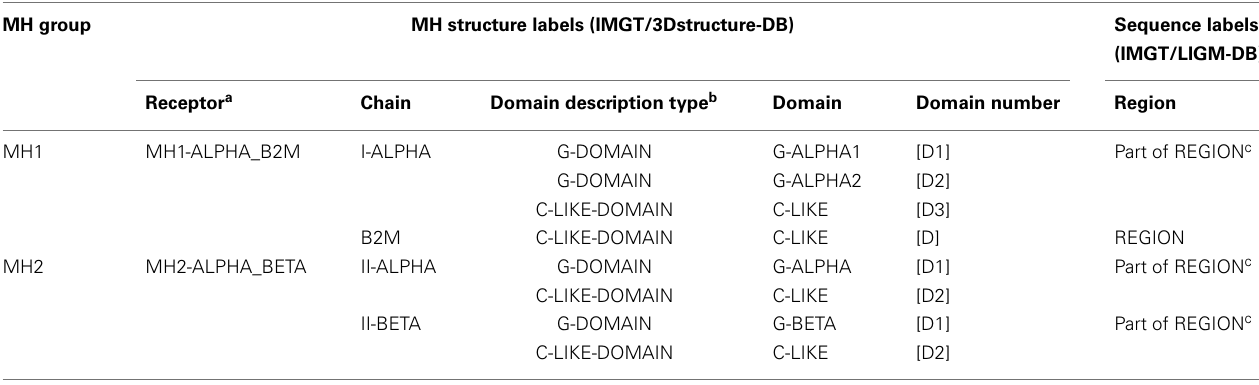
Table 3 | Major histocompatibility (MH) receptor, chain, and domain structure labels and correspondence with sequence labels . MH